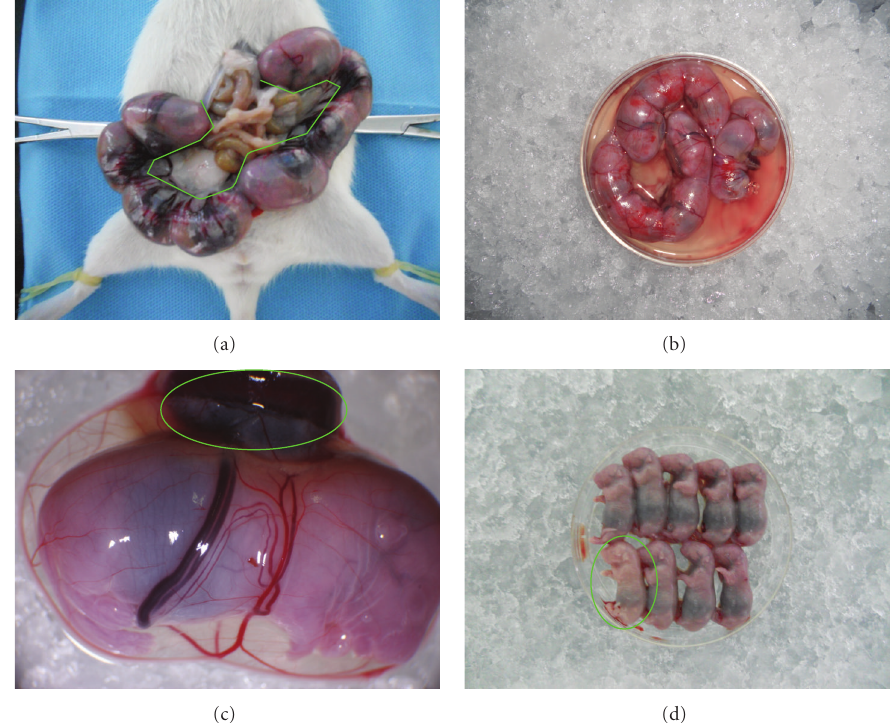
Figure 1: (a) The mesometrium and blood vessels were cut along the line as shown, (b) removal of the uterus, (c) removal of the placenta, (d) stillbirths